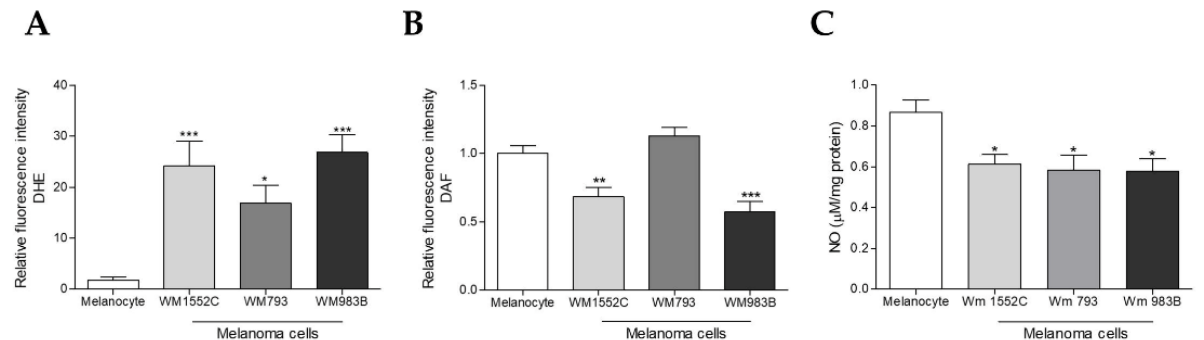
Figure 3. Melanoma cells show increased superoxide anion levels and decreased nitric oxide con- centrations. ( A ) O 2 •− amount in melanocytes and in WM1552C, WM973, and WM983B melanoma cells was analyzed by flow cytometry using DHE. The NO amount was evaluated by flow cytometry using DAF ( B ) or by the NO analyzer ( C ). Values are reported in the bar graphs and expressed as